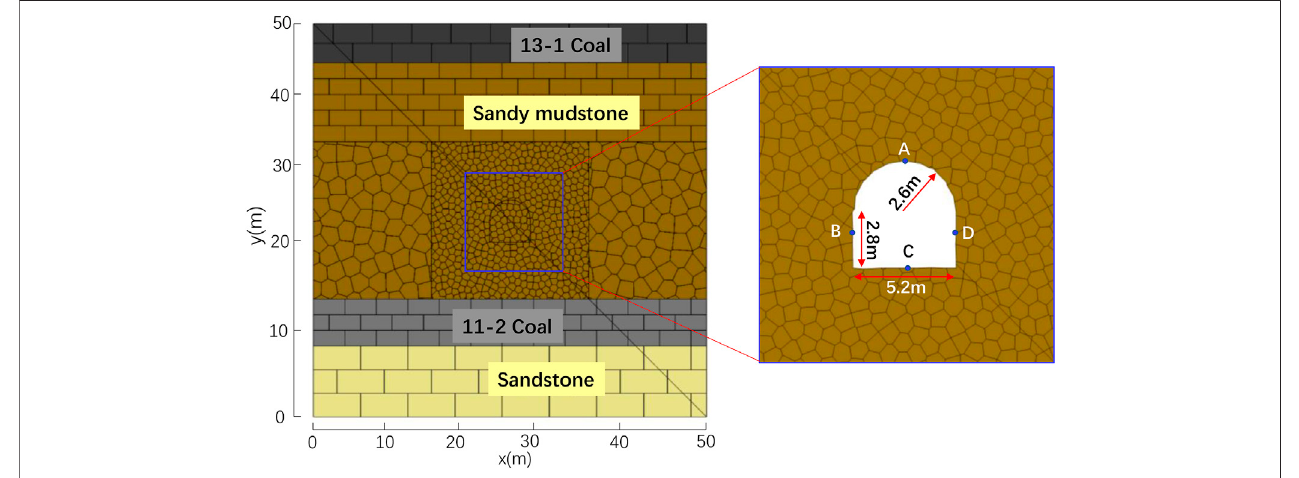
FIGURE 6 | UDEC numerical